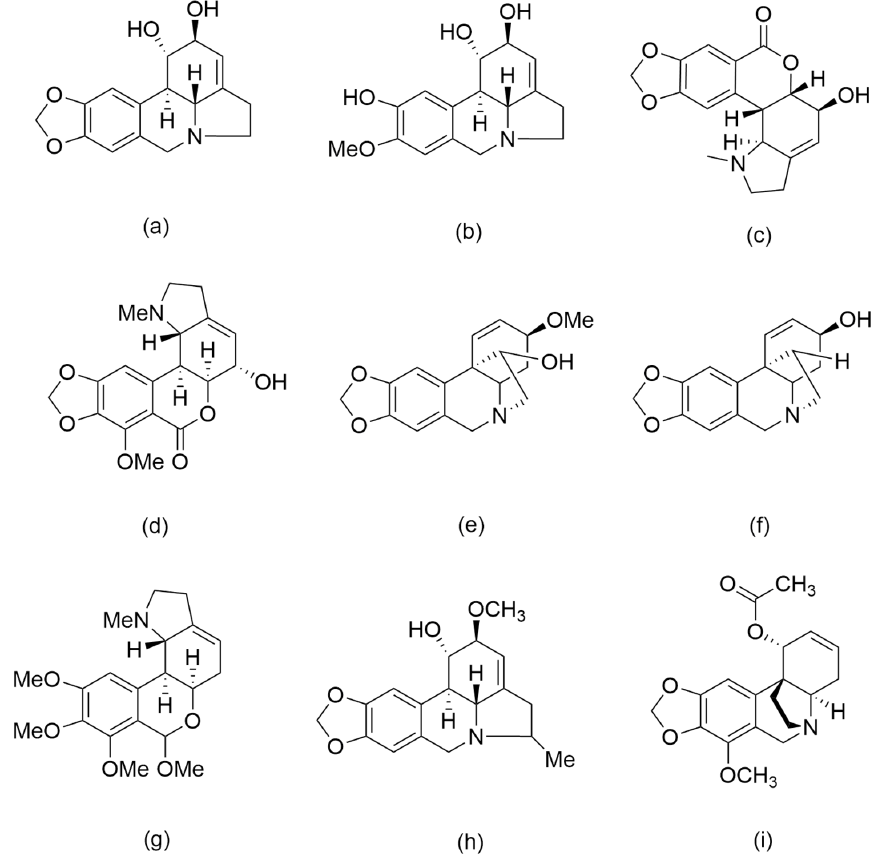
Figure 4. Lycorine ( a ), pseudolycorine ( b ), hippeastrine ( c ), candimine ( d ), haemanthamine ( e ), vittatine ( f ), 7-methoxy- O -methyllycorenine ( g ), 5-methyl-2-epihippamine ( h ) and 1- O -acetylbuphan- amine ( i ) .